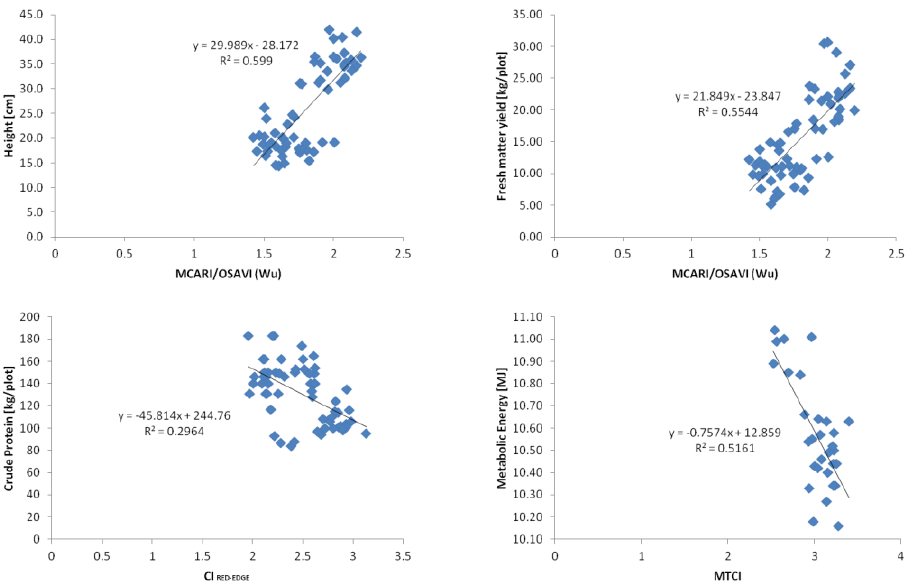
Figure 8. Scatterplot of the best relationships between selected grassland traits and vegetation indices. The best results of the linear regression model for height, fresh matter yield, and crude protein were found in the integrated dataset of May and October, including both organic and inorganic fertilizers; the best result for Metabolic Energy was found instead in the May dataset, combining both organic and inorganic fertilized